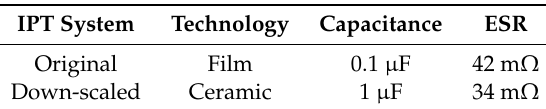
Figure 7. Adopted compensation capacitors. High-voltage film capacitor in yellow. Ceramic capacitor in orange. Table 7. Values of capacitance and equivalent series resistance (ESR) of two samples of the adopted compensation